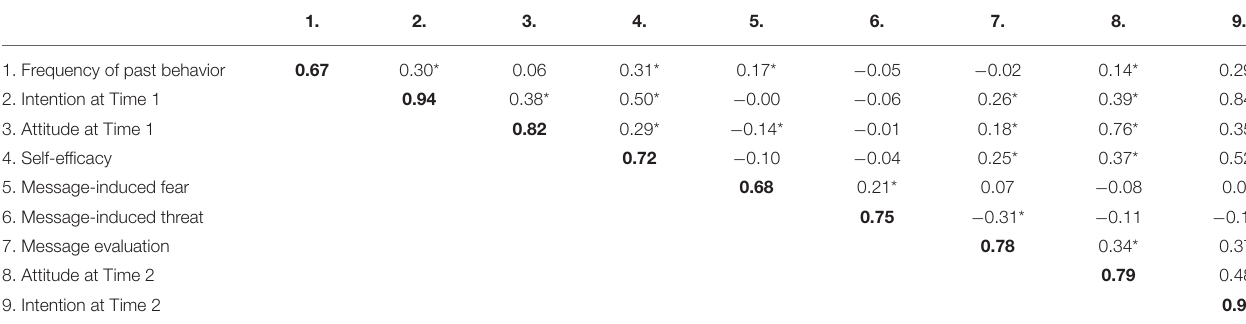
TABLE 2 | Convergent and discriminant